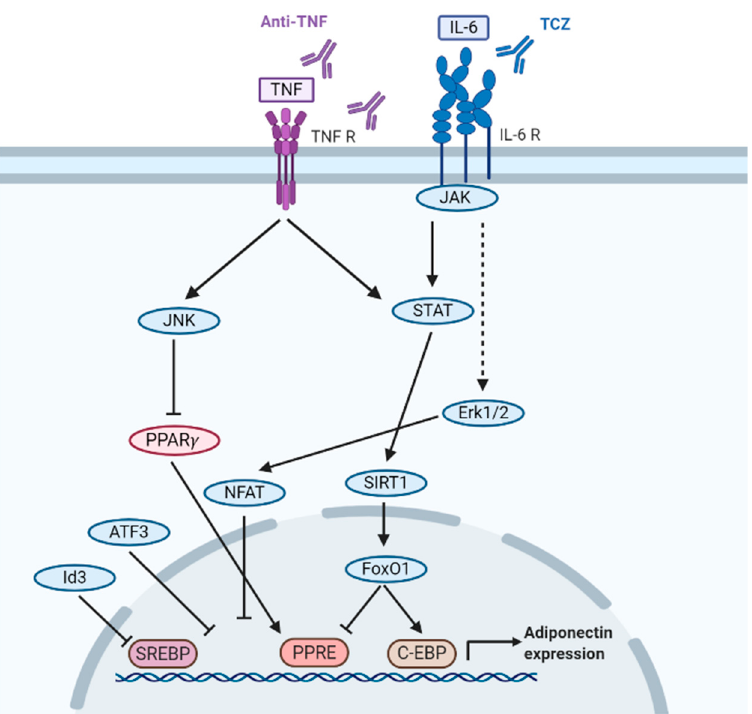
Figure 6. Simplified ADIPOQ gene regulation with TNF- α and IL-6. ATF3: Activating Transcription Factor 3, C-EBP: CCAAT-enhancer-binding protein, Erk1/2: extracellular signal-regulated kinases 1/2 FoxO1: Forkhead box protein O1, Id3: Inhibitor Of DNA Binding 3, IL: Interleukin, JAK: Janus kinase, JNK: Jun N-terminal kinase, NFAT: Nuclear factor of activated T-cells, PPAR- γ : Peroxisome- proliferator-activated receptor gamma, PPRE: Peroxisome proliferator response element, R: receptor, SIRT: Sirtuin, SREBP: Sterol regulatory element-binding protein, STAT: signal transducer and activator of transcription, TNF: Tumor necrosis